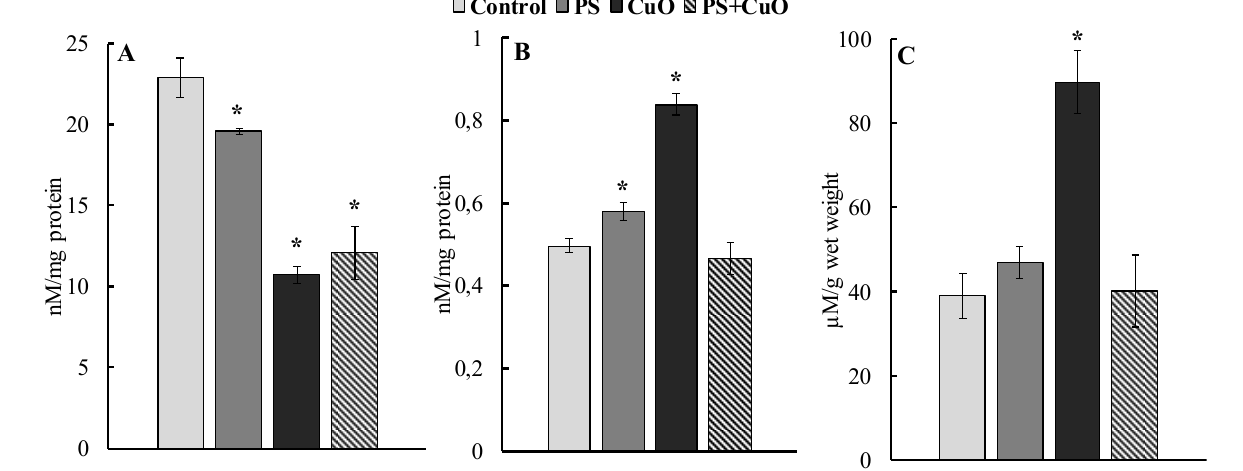
Figure 2. Changes in IAA ( A ), PC ( B ), and MDA ( C ) in M. trossulus tissues when exposed to µPSs and CuO (mean ± standard deviation, n = 30); *—difference from control is significant at p ≤ 0.05. While in mollusks exposed to µ PS the IAA level in the digestive gland cells was signif- icantly reduced by about 10% (from 22.87 ± 1.25 to 19.55 ± 0.21 nM/mg protein), when exposed to CuO-NPs, the IAA level decreased more than two-fold to 10.73 ± 0.53 nM/mg protein. This trend was maintained, and the IAA level also decreased significantly